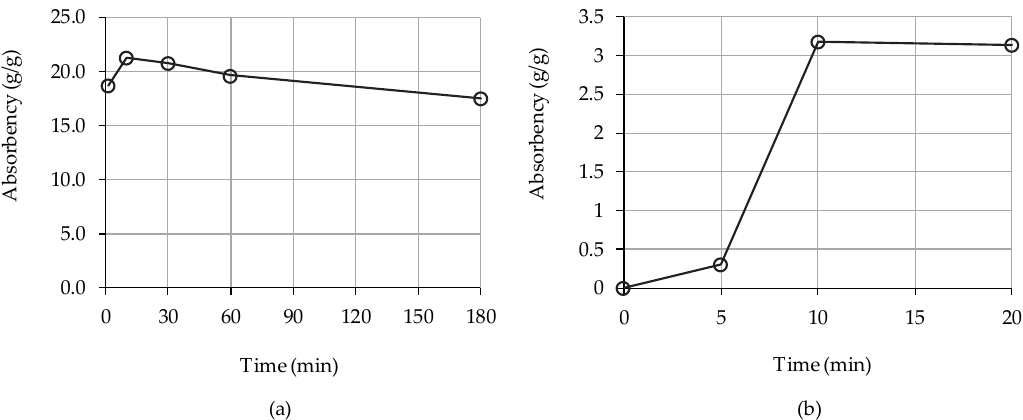
Figure 3. Absorbencies of the SAP_SPs in solution according to absorption time as measured by ( a ) tea bag test and ( b ) flow test.